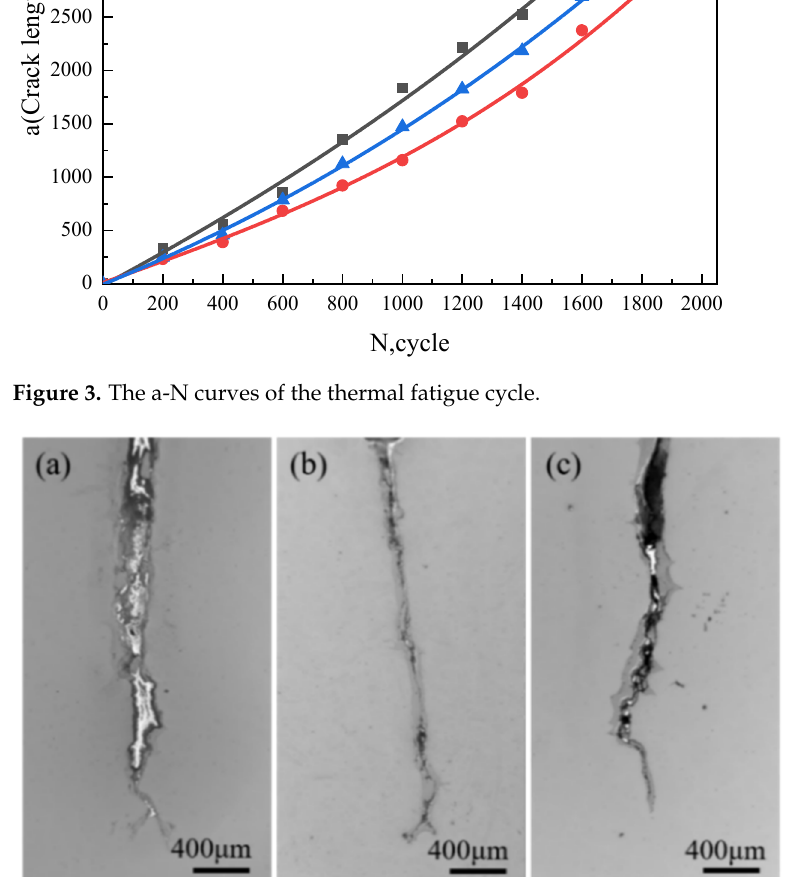
Figure 3. The a-N curves of the thermal fatigue cycle.